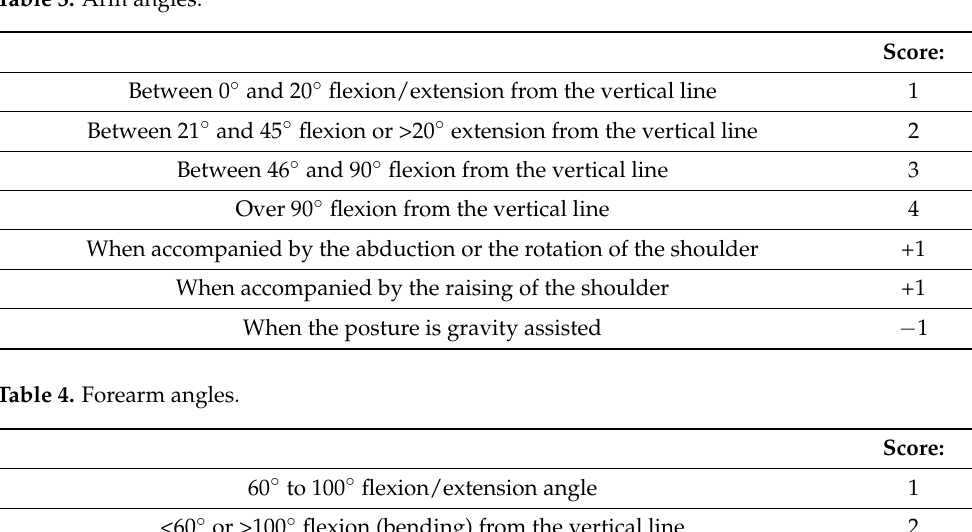
Score: Bilateral weight bearing, walking, or sitting 1 Between 30 ◦ and 60 ◦ knee flexion +1 Unilateral weight bearing, light support, or unstable posture 2 Over 60 ◦ knee flexion +2